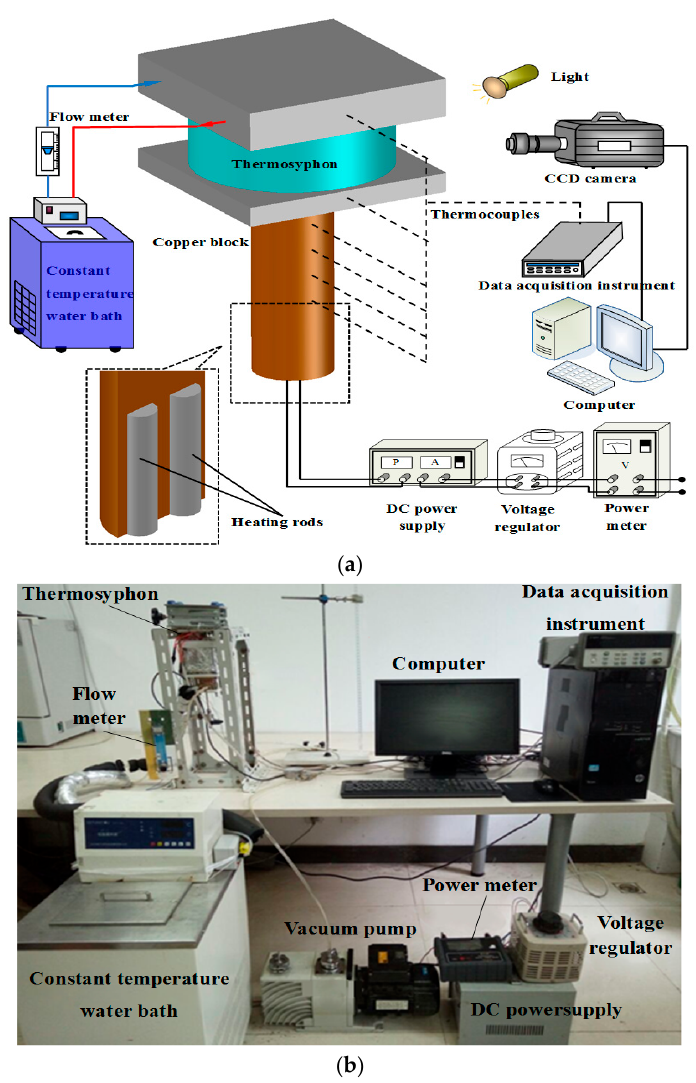
Figure 1. Schematic of experimental setup: ( a ) system diagram; ( b ) experimental rig.